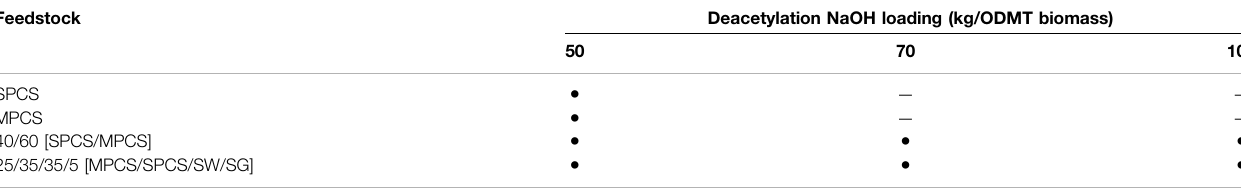
TABLE2| DeacetylatedfeedstocksthatalsounderwentDAPinthe4-Lsteamexplosionreactorat1%H 2 SO 4 ,150 ° C,20 minand1%H 2 SO 4 ,170 ° C,5 min,an “ that DAP was performed at two conditions on that deacetylated feedstock.